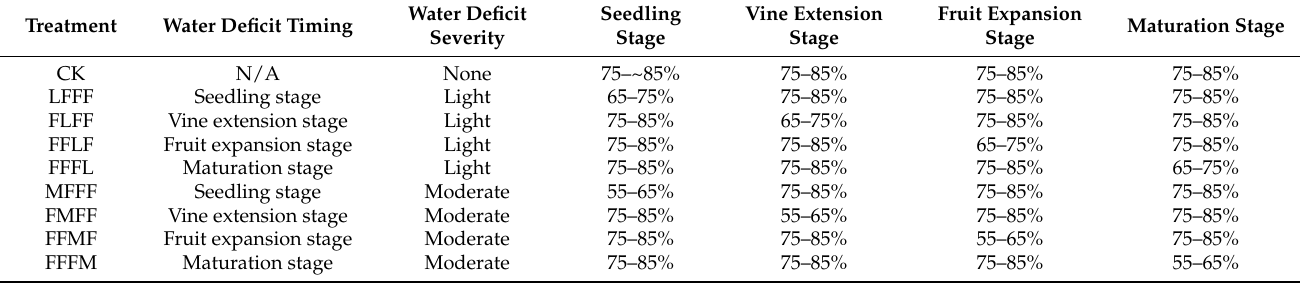
Figure 2. Planting diagram. Table 1. Experimental